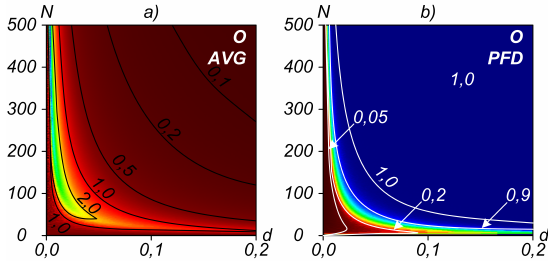
Figure 2: Average path length (a) and probability of finding decision (b) depending on the number of vertexes N and graph density d (optimal